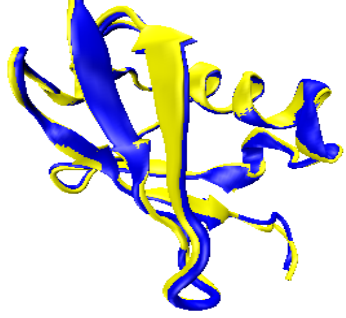
Figure 4. Superposition of two structures 1UBQ (blue) and 1D3Z (yellow) with bb-rmsd of 0.533 Å.